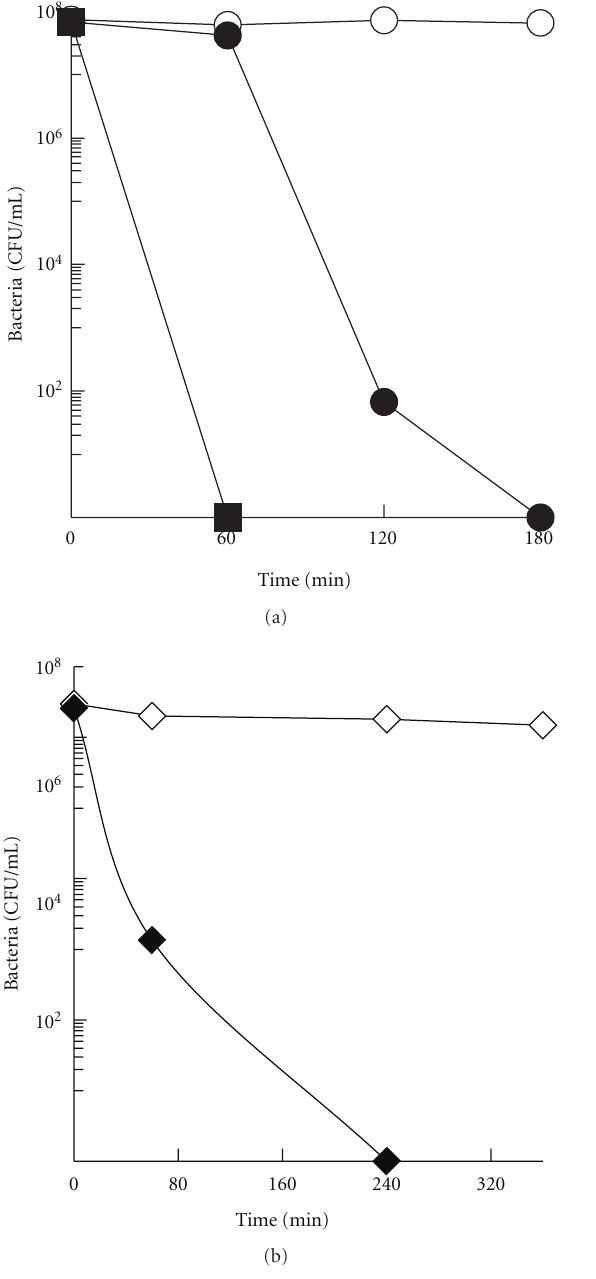
Figure 8: Dark events of E. coli with (a) ( Ag(2)TiO 2 , and ( (cid:4) ) TiO 2 samples and (b) filtered solutions of previously 10h stirred suspensions of (